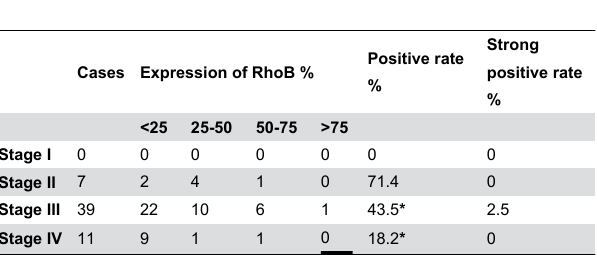
Table 2. Expression levels of RhoB and ovary carcinoma